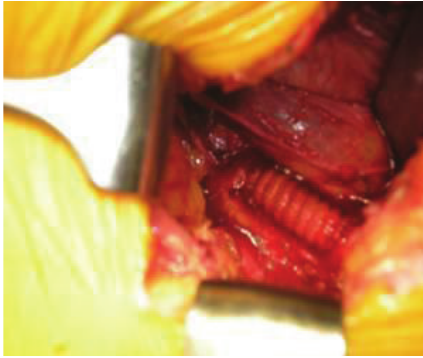
Figure 3: Reconstruction of external iliac artery with silver graft.